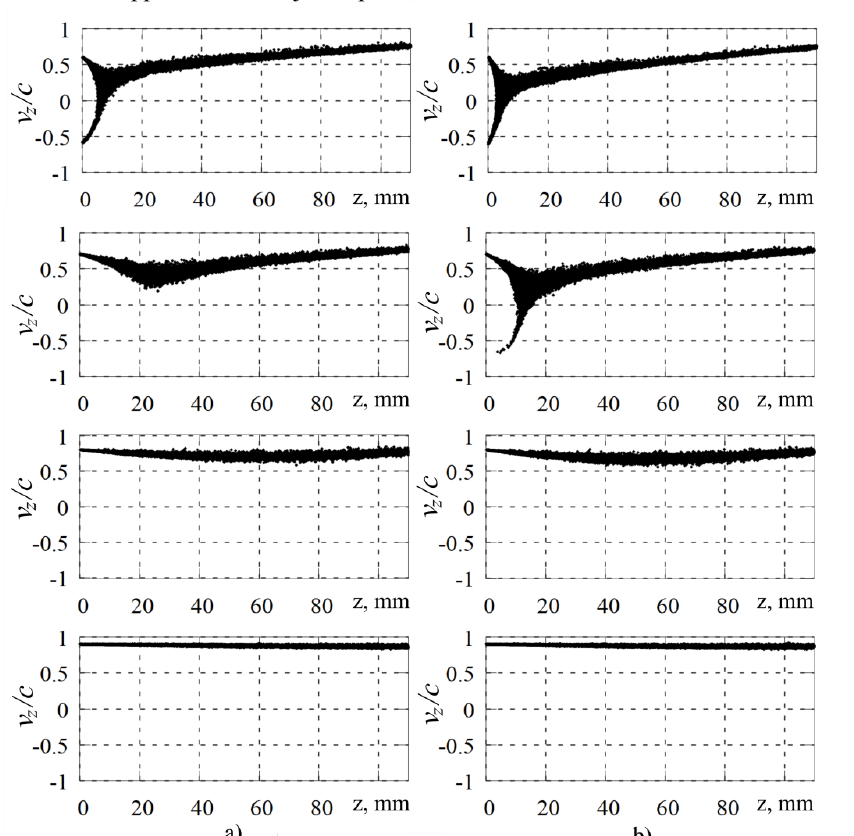
Fig. 5. Projections of the phase space of the electron beam in the (v z , z) plane with increasing beam velocity a) without taking into account the image field b) with the images. System parameters: I = 1 kA, B = 1 T, r = 5.48 mm, N = 30, Δ t = 1 ps, t = 600 ps. The velocity takes the values v = 0.6 c, 0.7 c, 0.8 c, 0.9 c (from top to